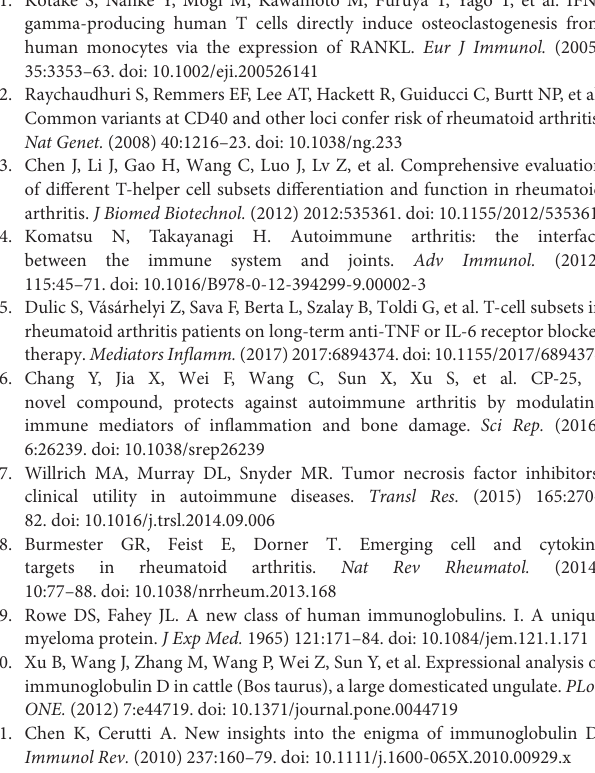
Supplementary Figure 1 | Effects of IgD-Fc-Ig (DG) on the proliferation of T cells in healthy controls and PBMCs in RA patients induced by IgD. Cells were incubated with IgD (3 µ g/ml) and different concentrations of IgD-Fc-Ig (1, 3 and 10 µ g/ml) for 48h. (A) Stimulation index of CD4 + T cells in healthy controls treated with IgD-Fc-Ig and IgD (3 µ g/ml) stimulation. (B) Stimulation index of PBMCs in RA patients treated with IgD-Fc-Ig and IgD (3 µ g/ml) stimulation. ∗ P < 0.05 vs. control, # P < 0.05 vs. IgD (3 µ g/ml) group. Supplementary Figure 2 | Effects of IgD-Fc-Ig (DG) on the mRNA expression of T cell subsets stimulated by IgD. PBMCs were cultured with different concentrations of IgD-Fc-Ig (1, 3 and 10 µ g/ml) combined with IgD (3 µ g/ml) for 48h. QPCR was used to analyze the mRNA expression level of T cell subsets. The mRNA expression of ROR γ t (A1), FoxP3 (A2), GATA3 (A3) and Tbet (A4) in healthy controls treated with IgD-Fc-Ig. The mRNA expression of ROR γ t (B1), FoxP3 (B2), GATA3 (B3) and Tbet (B4) in RA patients treated with IgD-Fc-Ig. Data were expressed as mean ± SEM ( n = 3). ∗ P < 0.05 and ∗∗ P < 0.01 vs. control, # P < 0.05 and ## P < 0.01 vs. IgD (3 µ g/ml)